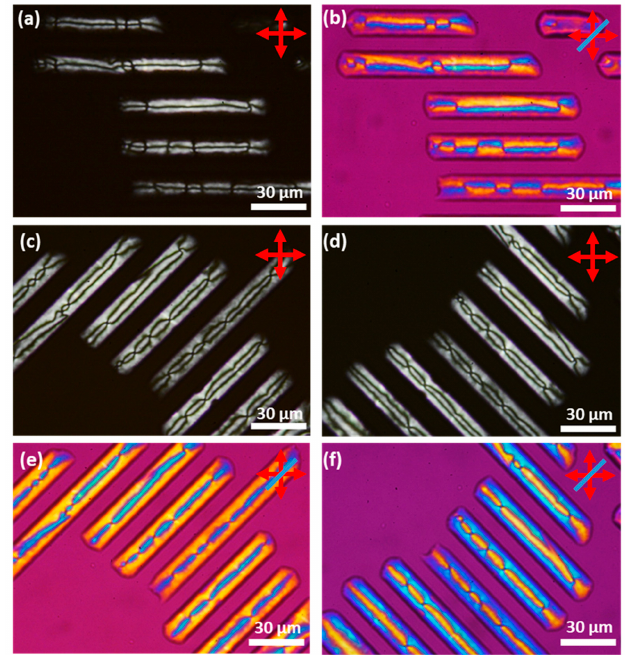
Figure 9. POM images for de ‐ wetted stripes of MLC2081. Hydrophilic stripes 15 μ m wide and hydrophobic stripes 10 μ m wide. ( a ) Crossed polarisers with the stripes parallel to one polarisa ‐ tion direction. ( b ) With an added wave plate. ( c , d ) Crossed polarisers with the stripes at +45° and − 45° to the vertical. ( e , f ) With an added wave plate. The blue line indicates the orientation of the slow axis of the compensator.